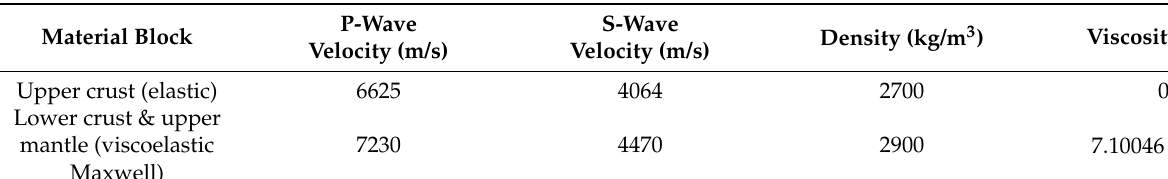
Table 1. Model parameters for each layer.